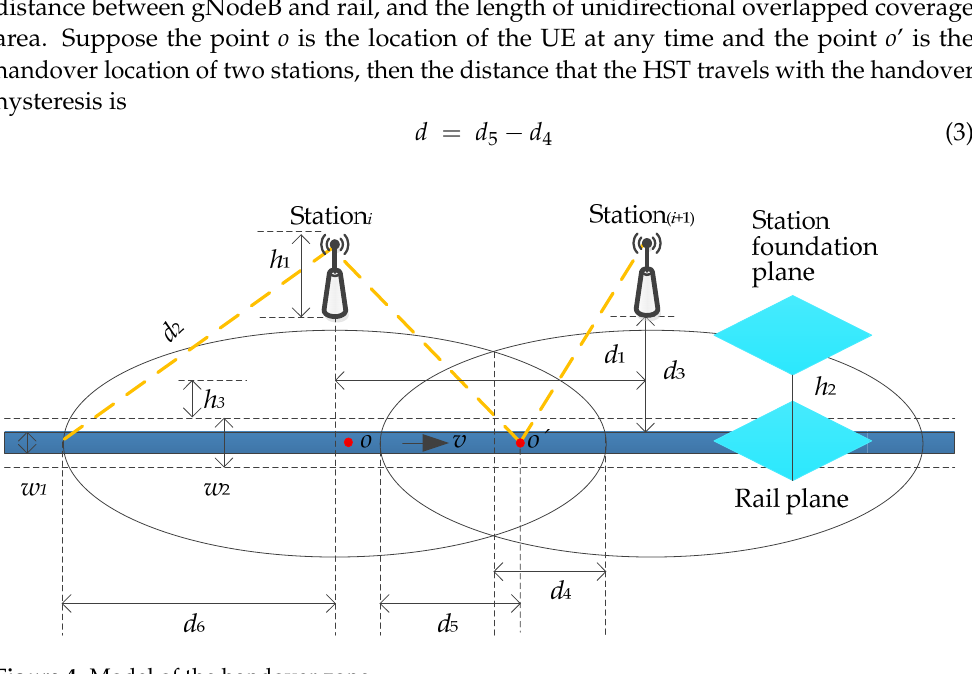
Figure 4. Model of the handover zone.